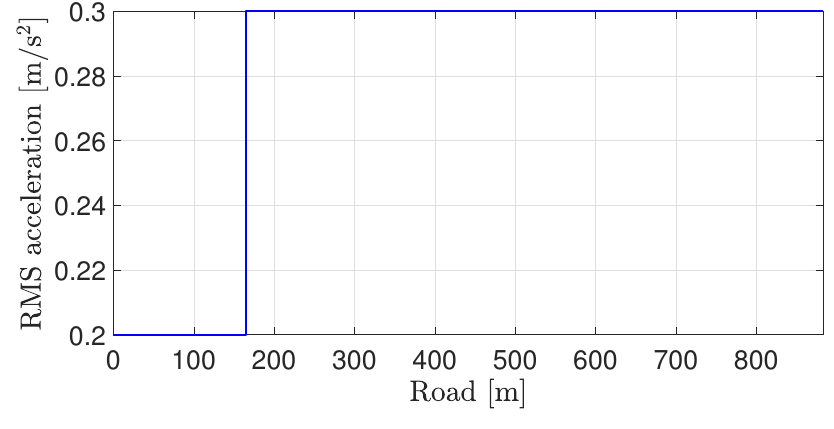
Figure 24. Desired comfort level.